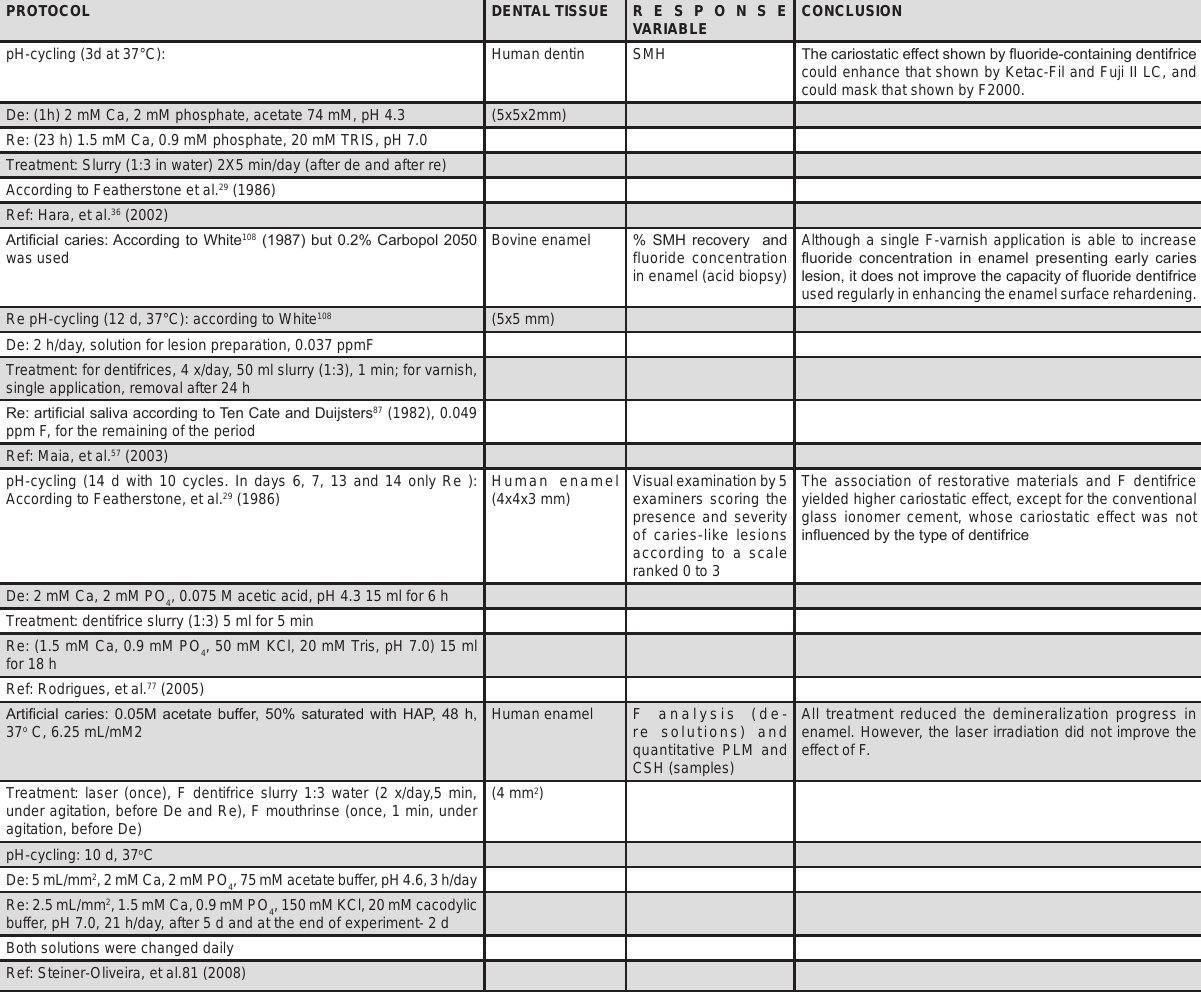
Human enamel F analysis (de- All treatment reduced the demineralization progress in enamel. However, the laser irradiation did not improve the re solutions) and quantitative PLM and effect of F. CSH (samples)